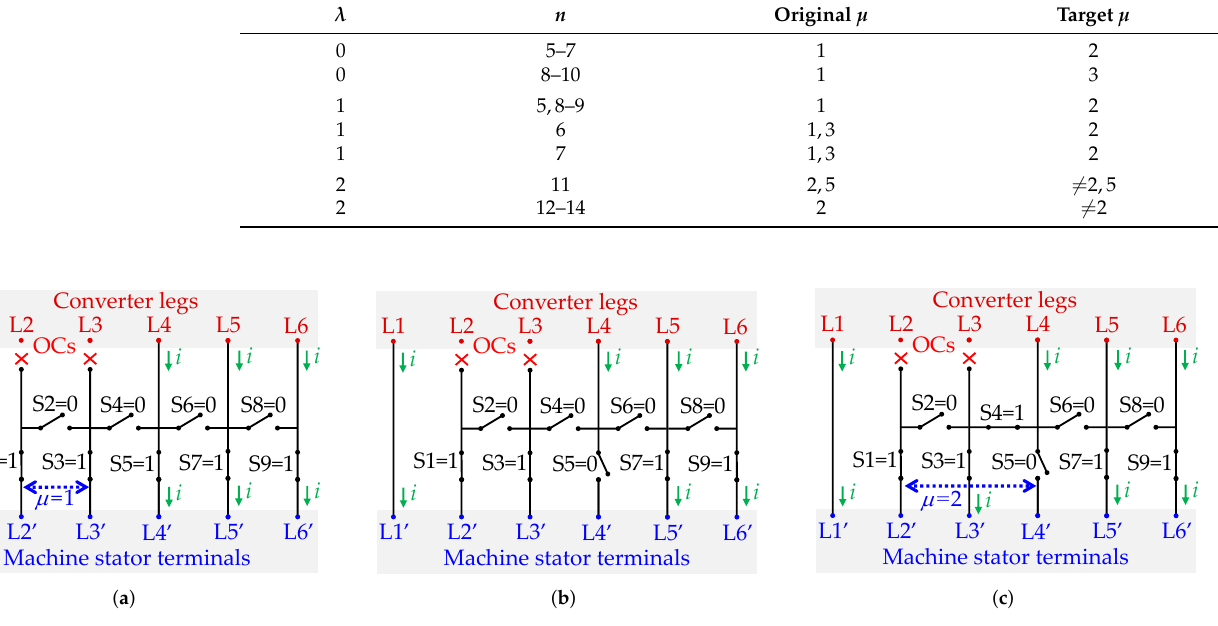
Figure 17. Reconfiguration following the sequence ( a – c ) from µ = 1 to µ = 2 by using an electric scheme between VSC and machine in order to improve the postfault performance for n = 6, λ = 0 (star), or λ = 1 (hexagon), and symmetrical WSA, under OCs in VSC legs/lines L2 and L3